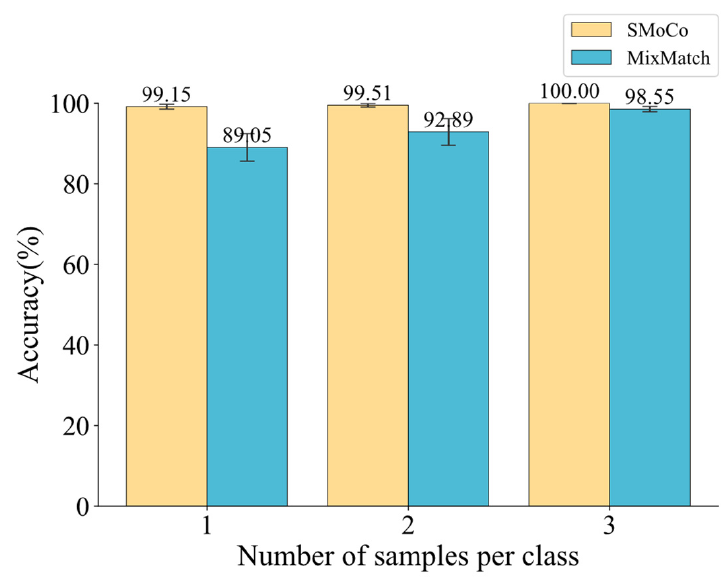
Figure 16. Comparison of results under different training set sizes on dataset 3.